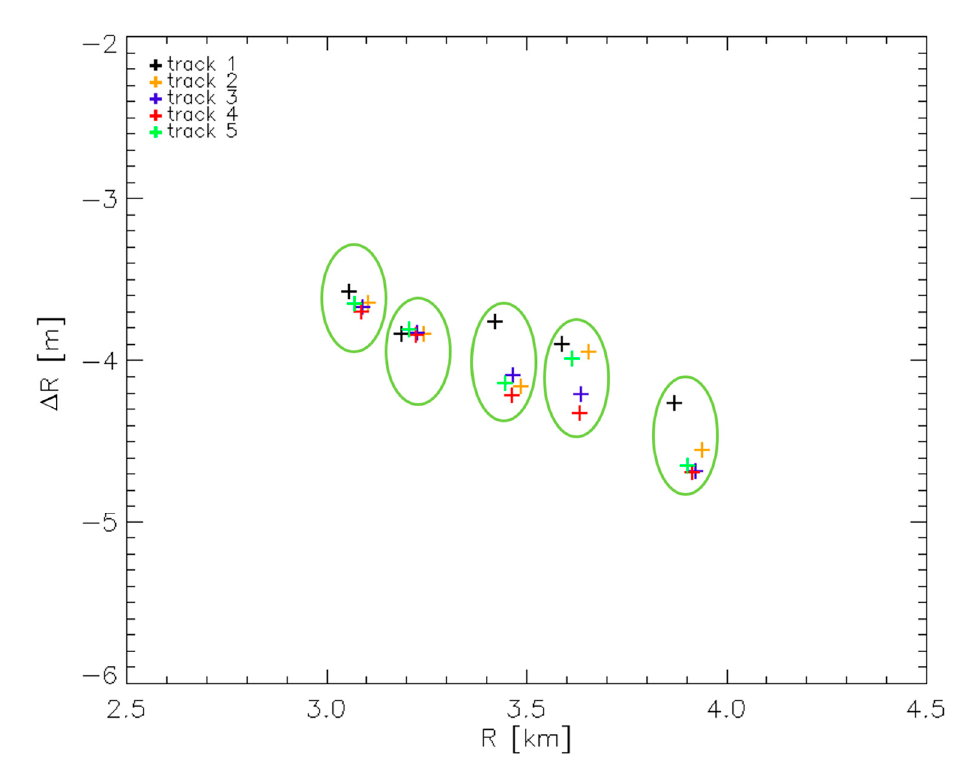
Figure 10. Relevant to Equation (3), to the 5 CRs and the 5 acquisitions considered in the Experiment 6: difference Δ R as a function of the CRs-to-radar distances R. Each color indicates a different radar acquisition. Each green circle groups the same CR in the five different acquisitions.